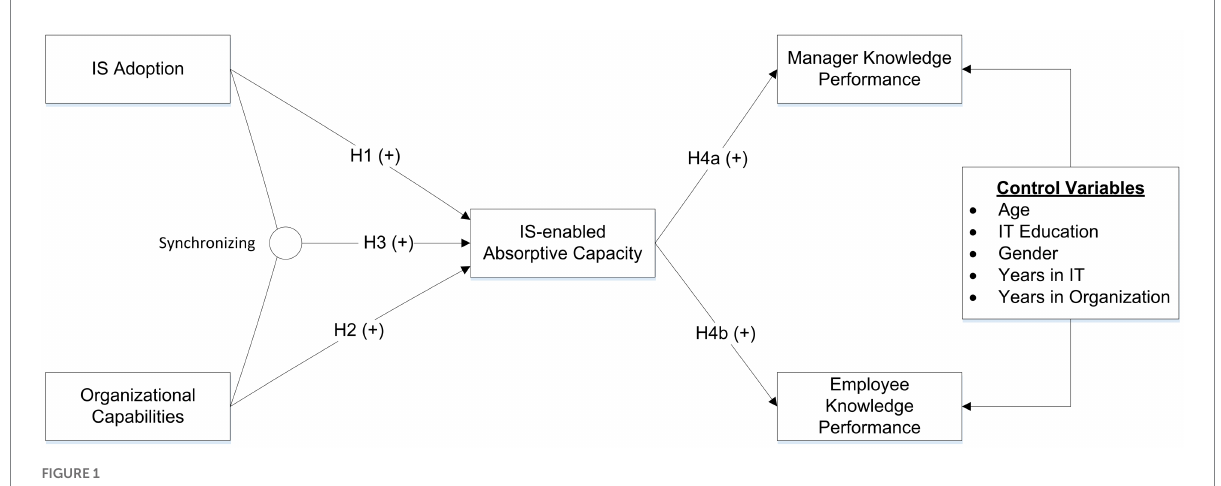
FIGURE 1 Research